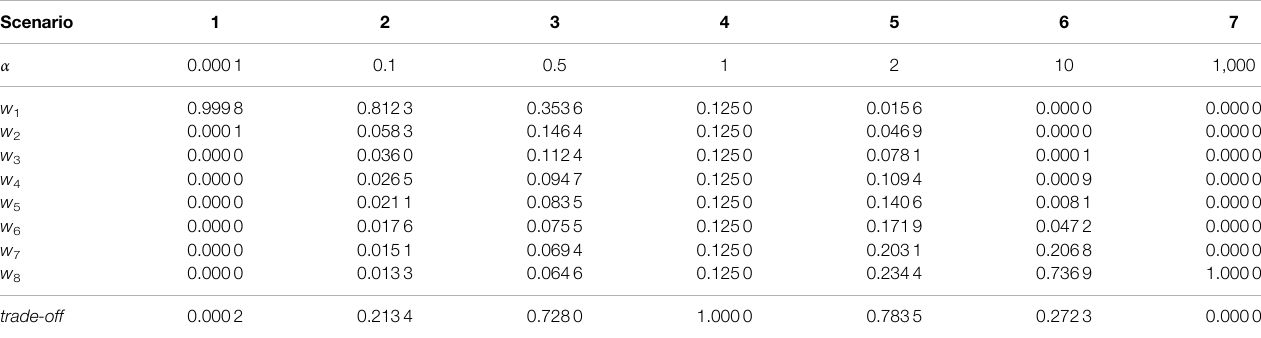
TABLE 2 | Bit order weight operators under different decision risk